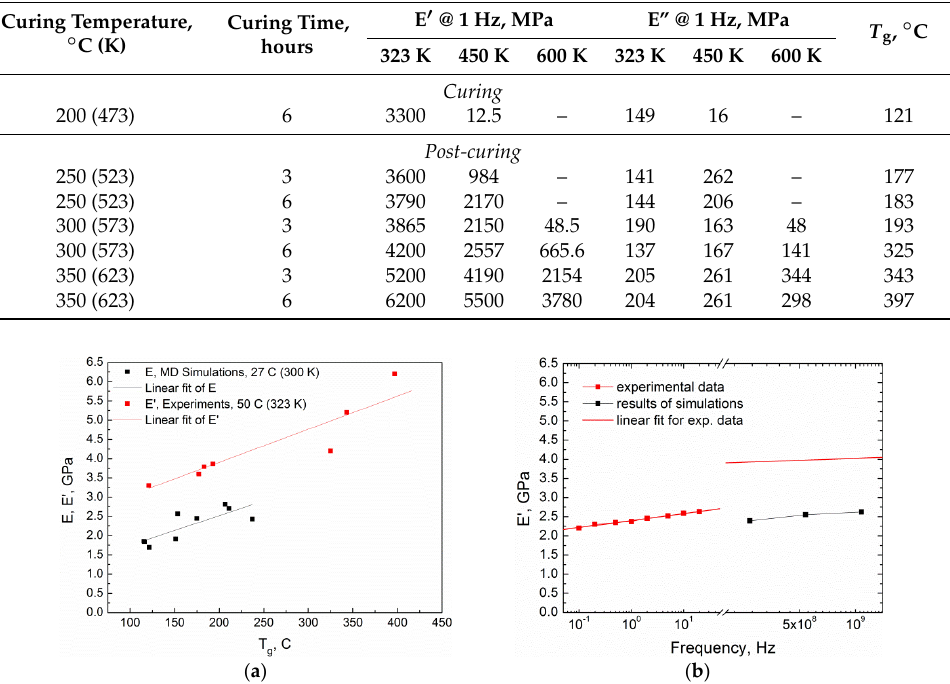
Figure 6. Comparison of the moduli of elasticity in dissipative particle dynamics (DPD) and molecular dynamics (MD) simulations (at T = 600 K). The relation between the two scales (DPD and MD) was chosen by fitting these two datasets with a fixed zero level. Table 1. Experimental data on dynamic mechanical analysis (DMA) measurements: Glass transition temperatures and dynamic moduli at 323 K, 450 K, and 600 K for the samples prepared at various curing temperatures and curing times. E (cid:48) and E” were measured at 1 Hz frequency with a relative error bar about 4.0%. T g was measured with a precision of 4 ◦ C.